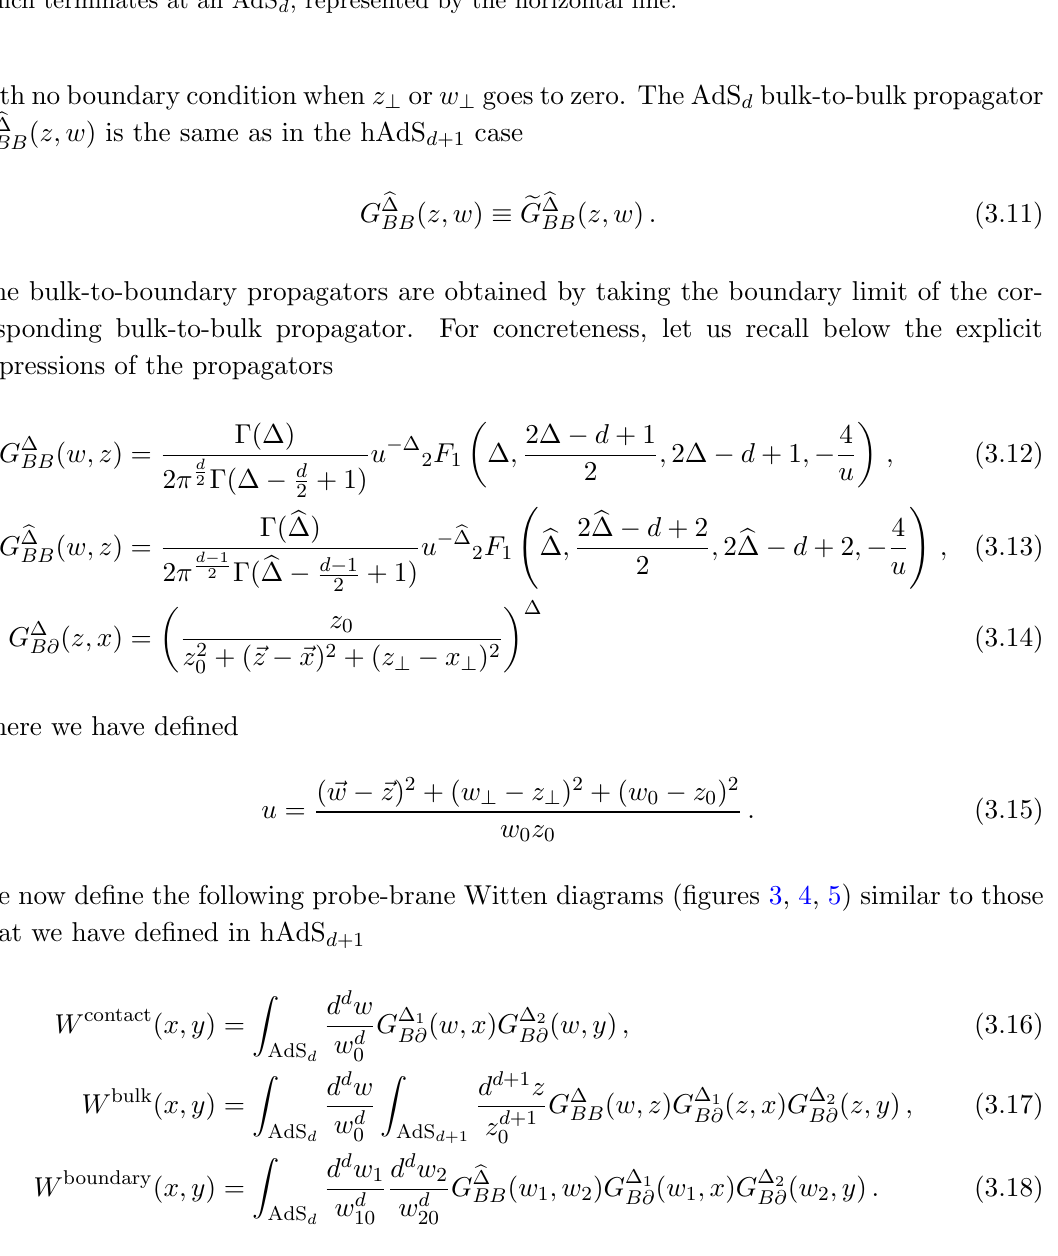
. The semi-disk represents the hAdS N d +1